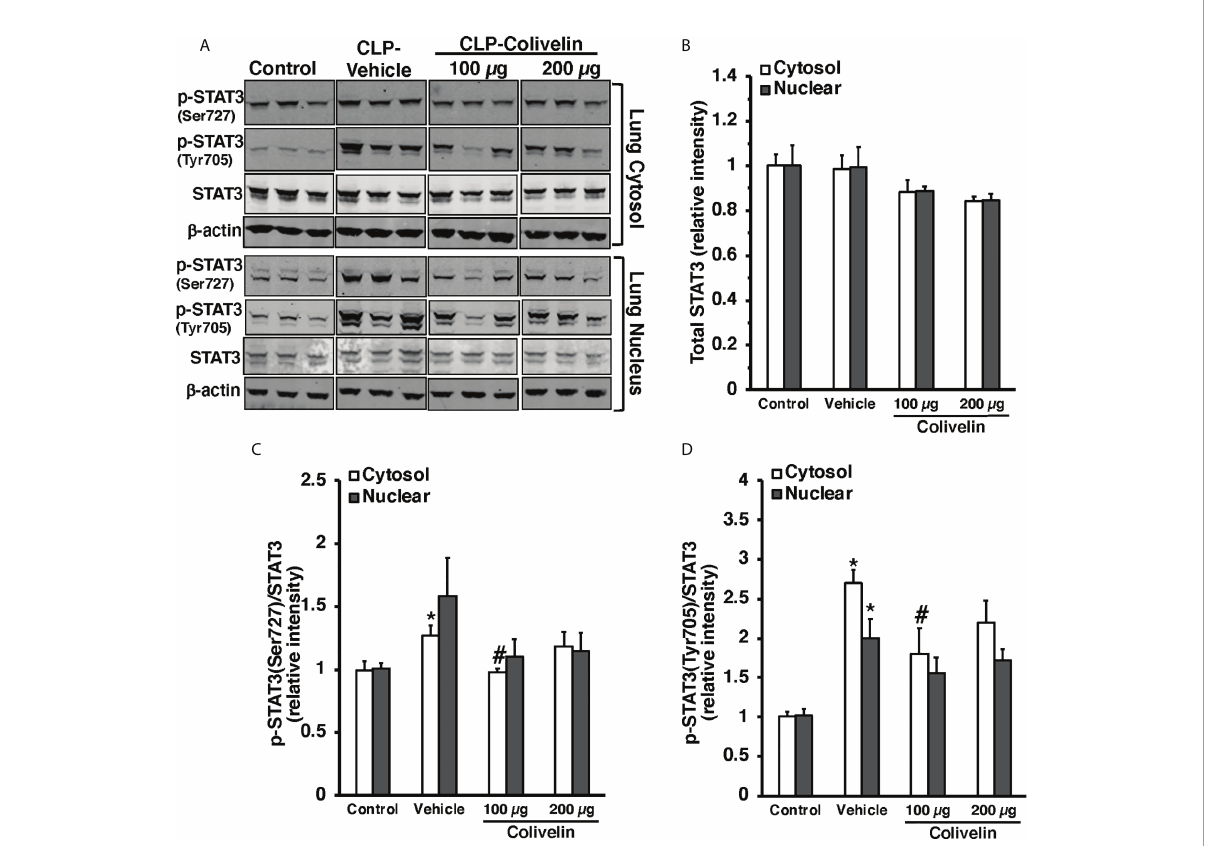
FIGURE 8 Representative Western blots of total STAT3, p-STAT3(Ser727) and p-STAT3(Tyr705) in lung cytosol and nuclear extracts; b -actin was used as loading control protein (A) . Image analyses of cytosol and nuclear of relative intensity of total STAT3 (B) , ratio of p-STAT3(Ser727)/STAT3 (C) , and ratio of p-STAT3(Tyr705)/STAT3 (D) as determined by densitometry. Vehicle (200 µl distilled water) or colivelin (100 µg/kg) was administered intraperitoneally at 1 h after CLP. Each data represents the mean ± SEM of 3-4 mice for group (n=3 control group, n=4 vehicle group, n=4 colivelin 100 µg group). *Represents P < 0.05 versus control mice; #represents P < 0.05 versus vehicle-treated